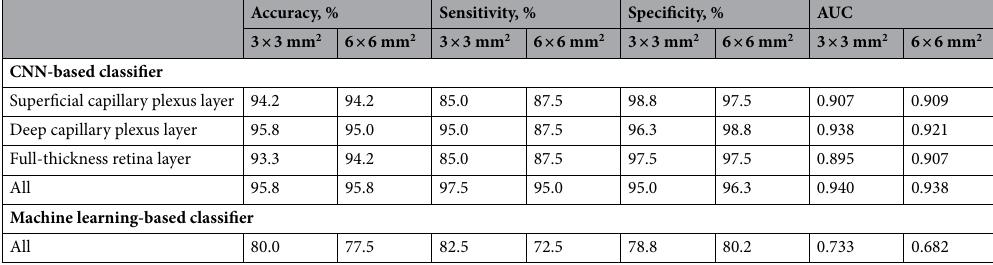
Table 4. Performance of classification task on external dataset for detecting referable status of diabetic retinopathy using the proposed deep learning- and machine learning-based classifiers. AUC area under the curve, CNN convolutional neural network, SD standard deviation.